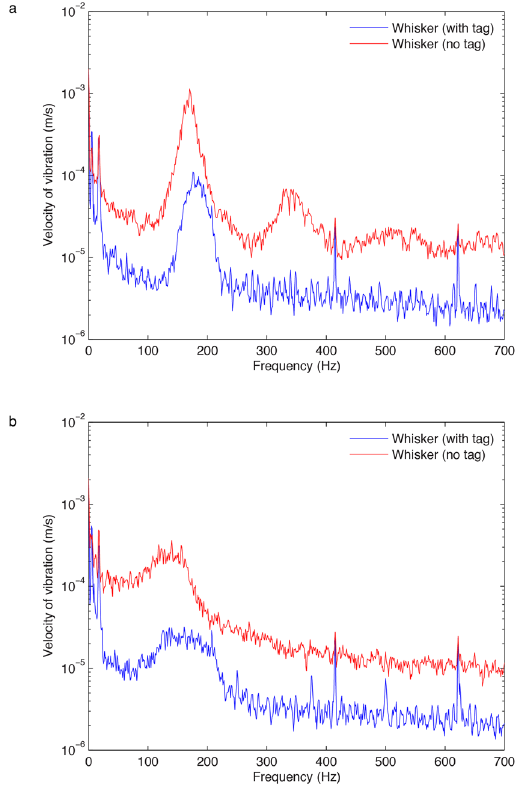
Figure 2. Overlaid velocity magnitude spectra for a representative recording of an excised whisker with and without the accelerometer, tested in a flume tank. ( a ) Vibration in free-flow condition. ( b ) Vibration in disturbance condition. Matching shapes of the spectra are seen between the whisker with and without the tag. This indicates that the attachment of the accelerometer caused some attenuation of the signal amplitude but the vibration pattern was still faithfully